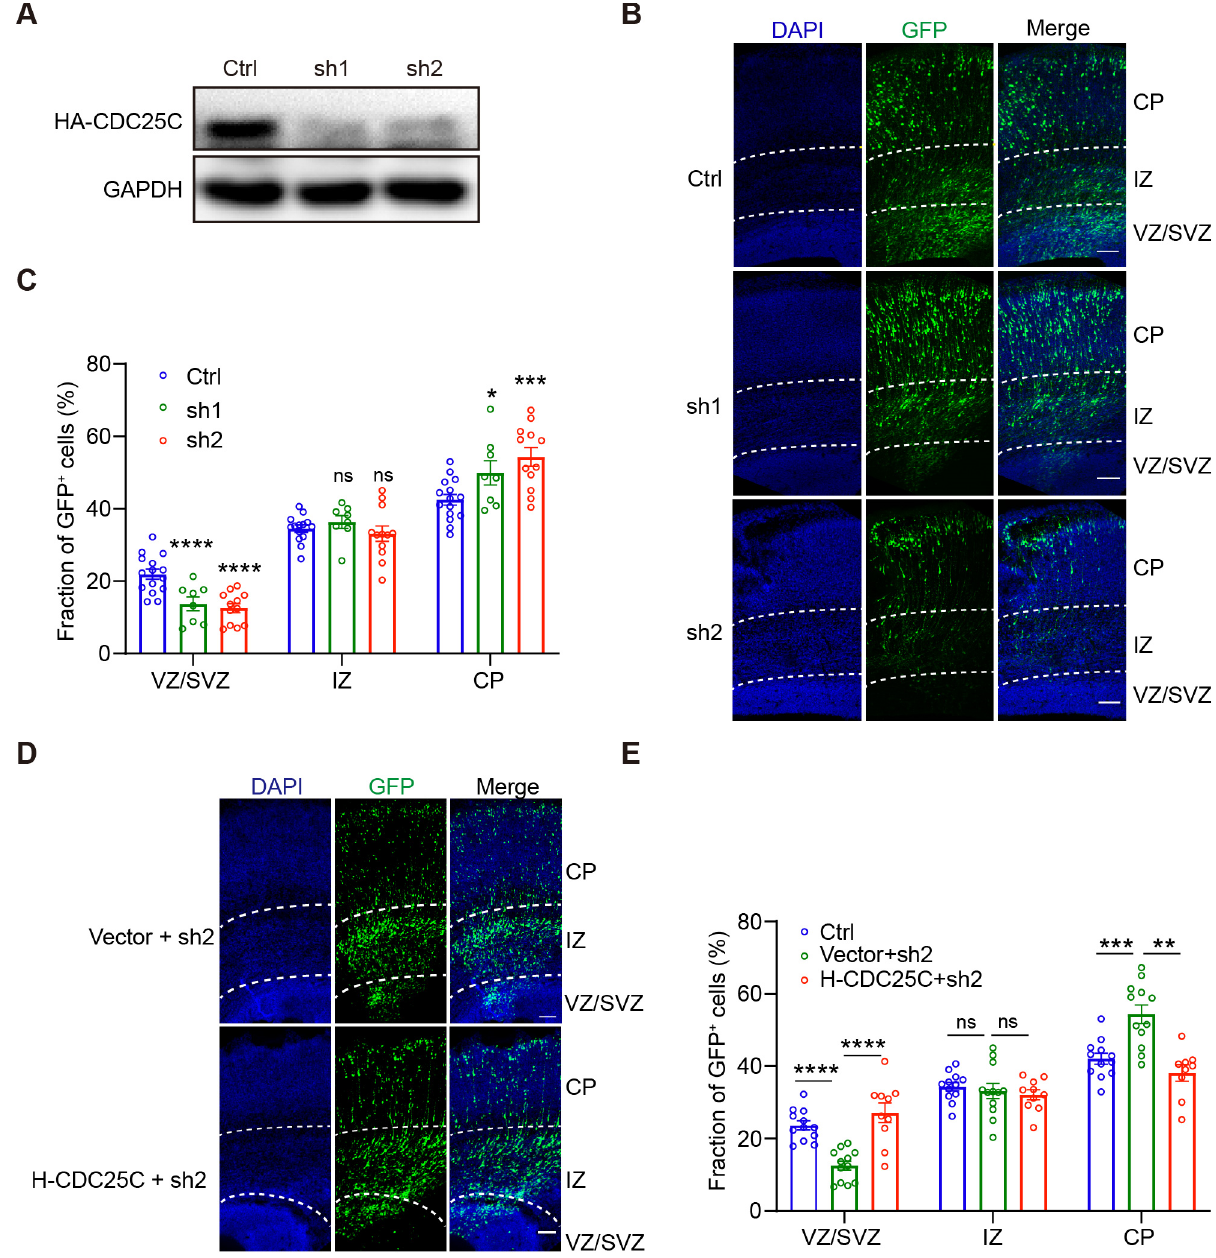
Figure 2. Cdc25c knockdown leads to altered cell distribution in the cortex, which can be rescued by human CDC25C overexpression. ( A ) HEK293 cells were transfected with scrambled (Ctrl) or Cdc25c shRNAs (sh1, sh2) together with mouse Cdc25c cDNA; 24 h later, cell lysates were analyzed by immunoblotting with anti-HA antibody, and with GAPDH serving as loading control. ( B ) Coronal sections of rat brains electroporated with Ctrl or Cdc25c shRNAs at E16.5 and inspected at E20.5. Slices were stained with DAPI to label nuclei. ( C ) Quantification of cell distribution in ( B ). Data are mean ± SEM. ns p > 0.05, * p < 0.05, *** p < 0.005, **** p < 0.0001, one-way ANOVA. Individual data showed brain slice number from Ctrl, n = 7; sh1 and sh2, n = 5 independent mice. ( D ) Coronal sections of rat brains electroporated with Cdc25c sh2 together with empty vector or vector expressing human CDC25C at E16.5 and inspected at E20.5. ( E ) Quantification of cell distribution in ( D ). Data are mean ± SEM. ns p > 0.05, ** p < 0.01, *** p < 0.005, **** p < 0.0001, one-way ANOVA. Individual data showed brain slice number from Ctrl n = 7, vector + sh2, n =3; H-CDC25C + sh2, n = 4 independent mice. Scale bars, 100 μ m ( B , D ).